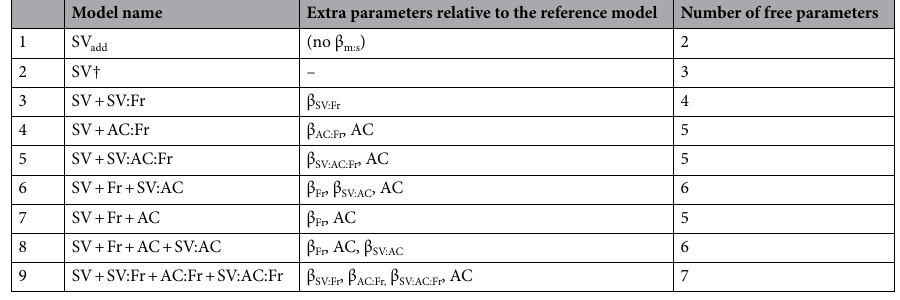
Table 1. Name and parametrization of all candidate models. m = money; s = shocks; AC = action context; SV = subjective value, Fr = umbrella term for freeze indices: each model was fitted once with bradycardia and once with body sway (reported in supplements); SV add = additive SV model; †reference model; colons (:) denote